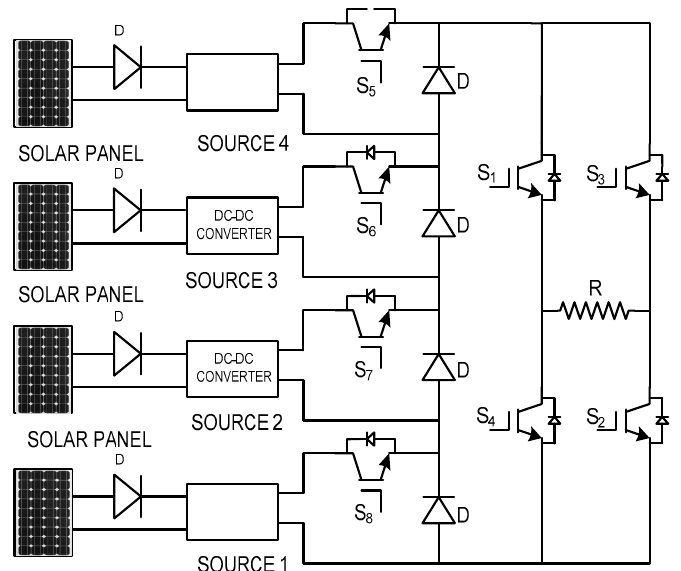
Figure 7. 15-level reduced switch multilevel inverter.